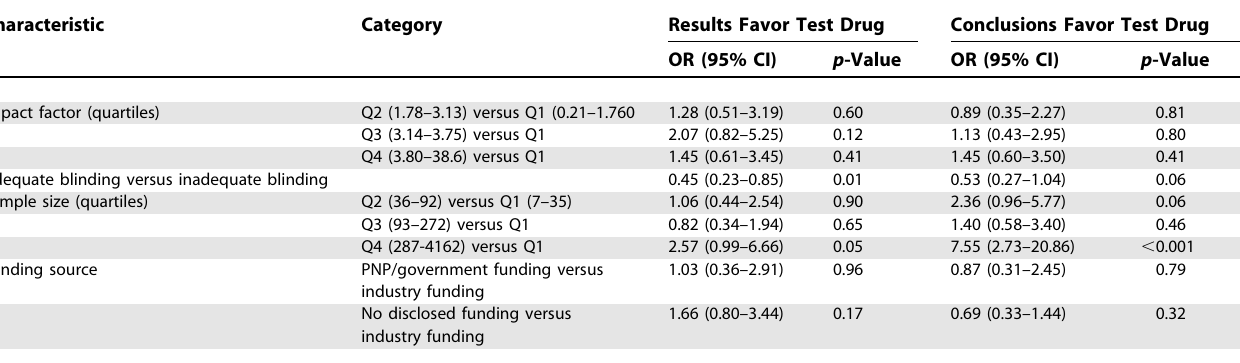
Table 3. Association between Characteristics of Manuscripts ( n ¼ 192) and Results or Conclusions that Favor Test Drug: Multivariate Analysis Characteristic Category Results Favor Test